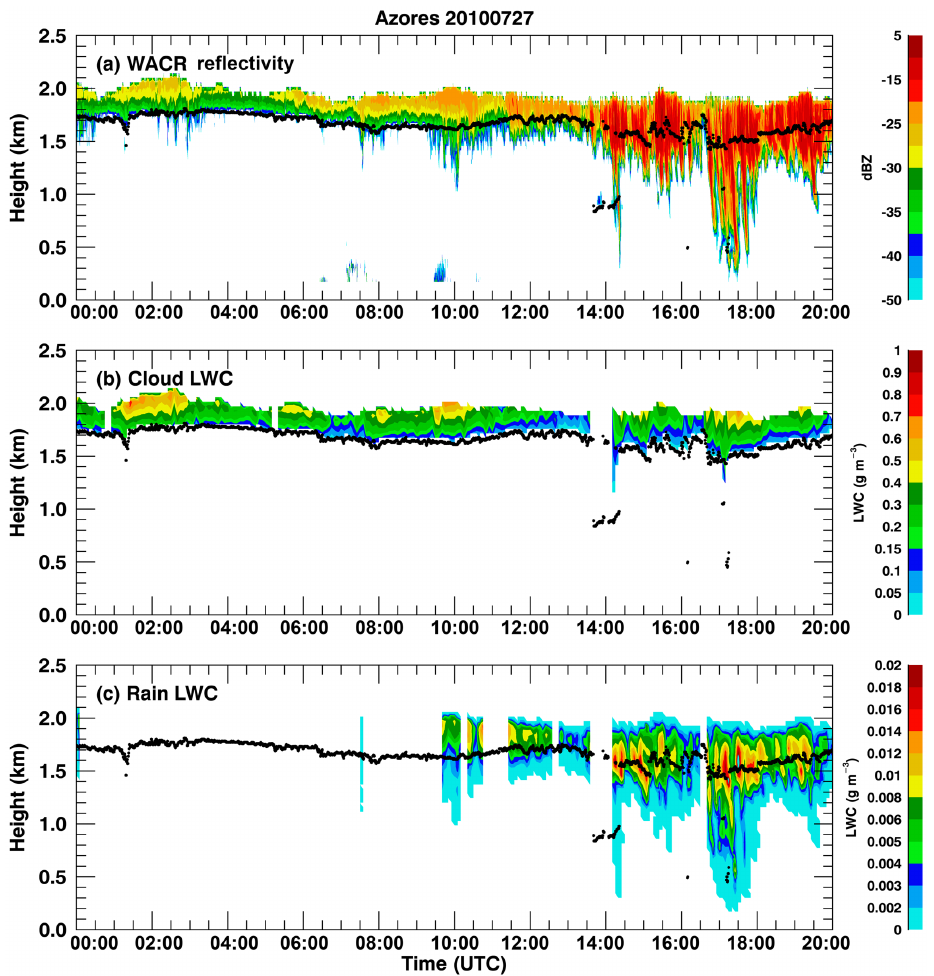
Figure A1. Joint retrieval of cloud and rain liquid water content (CLWC and RLWC) for the same case as in Fig. 1. (a) WACR reflectivity, (b) CLWC, and (c) RLWC. The black dots represent cloud-base height. Blank gaps are a result of the data from one or more observations being not available or reliable. For example, the gap before 14:00UTC is due to multiple cloud layers, whereas we only focus on a single layer